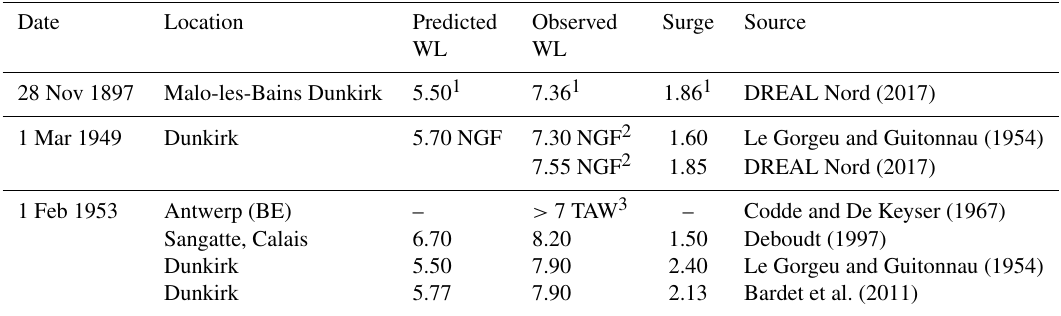
Table 1. Date, localization, water and surge levels (m) of collected storms within Nord-Pas-de-Calais